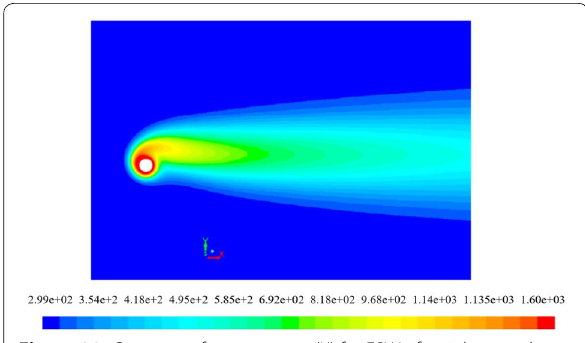
Figure 38 Contours of temperature (K) for FSW of stainless steel alloy